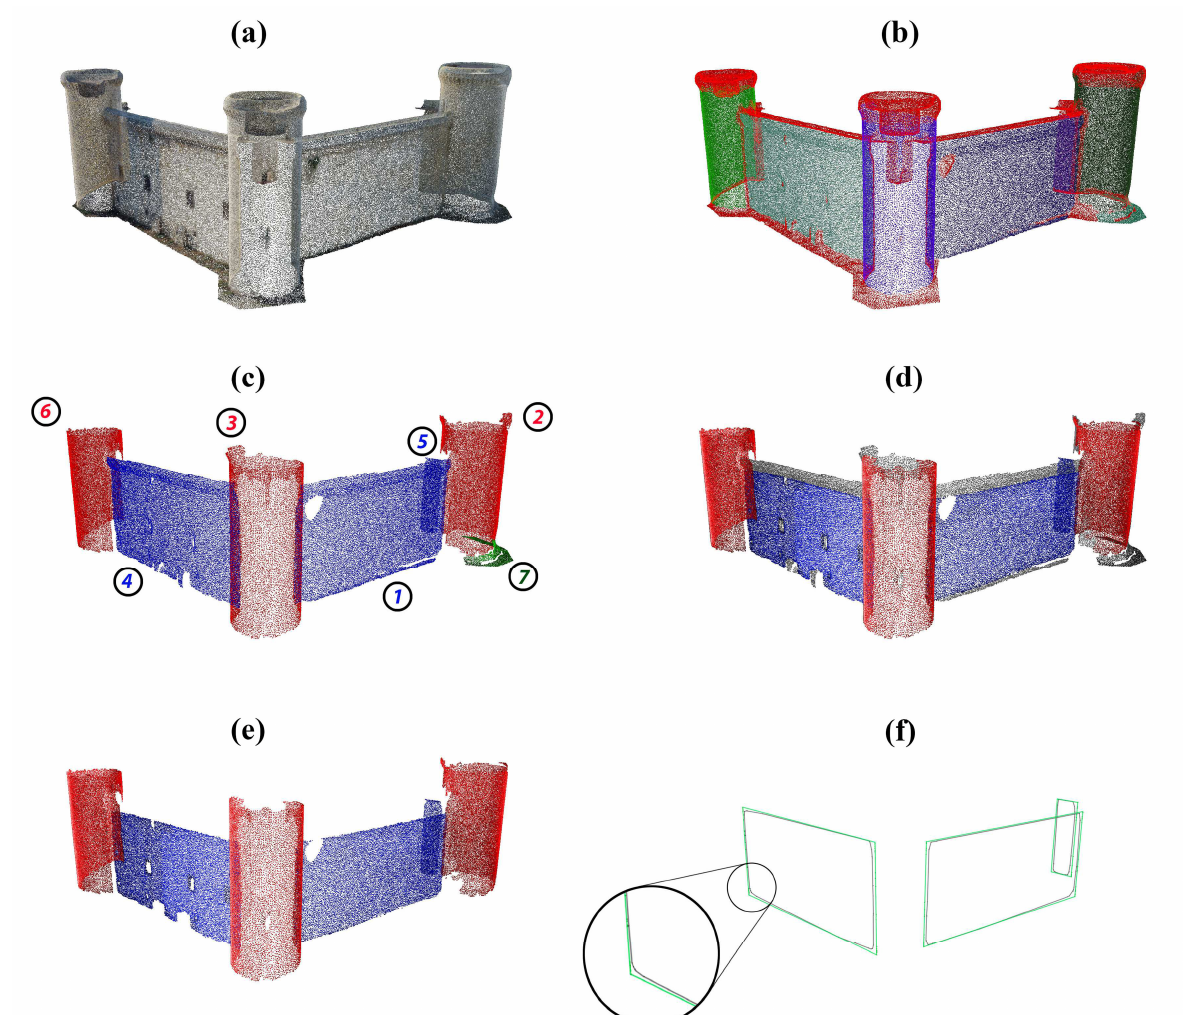
Figure 3: a) Preprocessed; b) Segmented; c) Primitives (cylinders in red, walls in blue, undefined in green); d) Inliers and outliers (grey); e) Projected inliers; f) Parametrization and improved shape